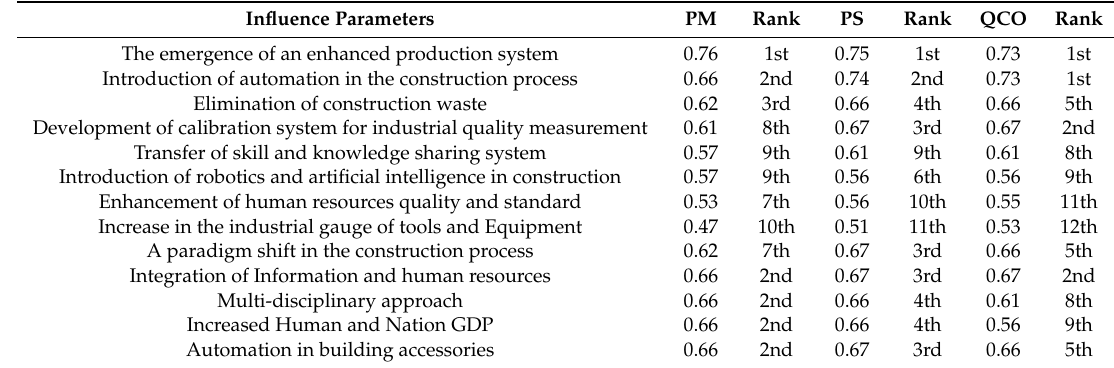
Table 9. Influence and relevance of construction 4.0 and lean thinking concept in construction